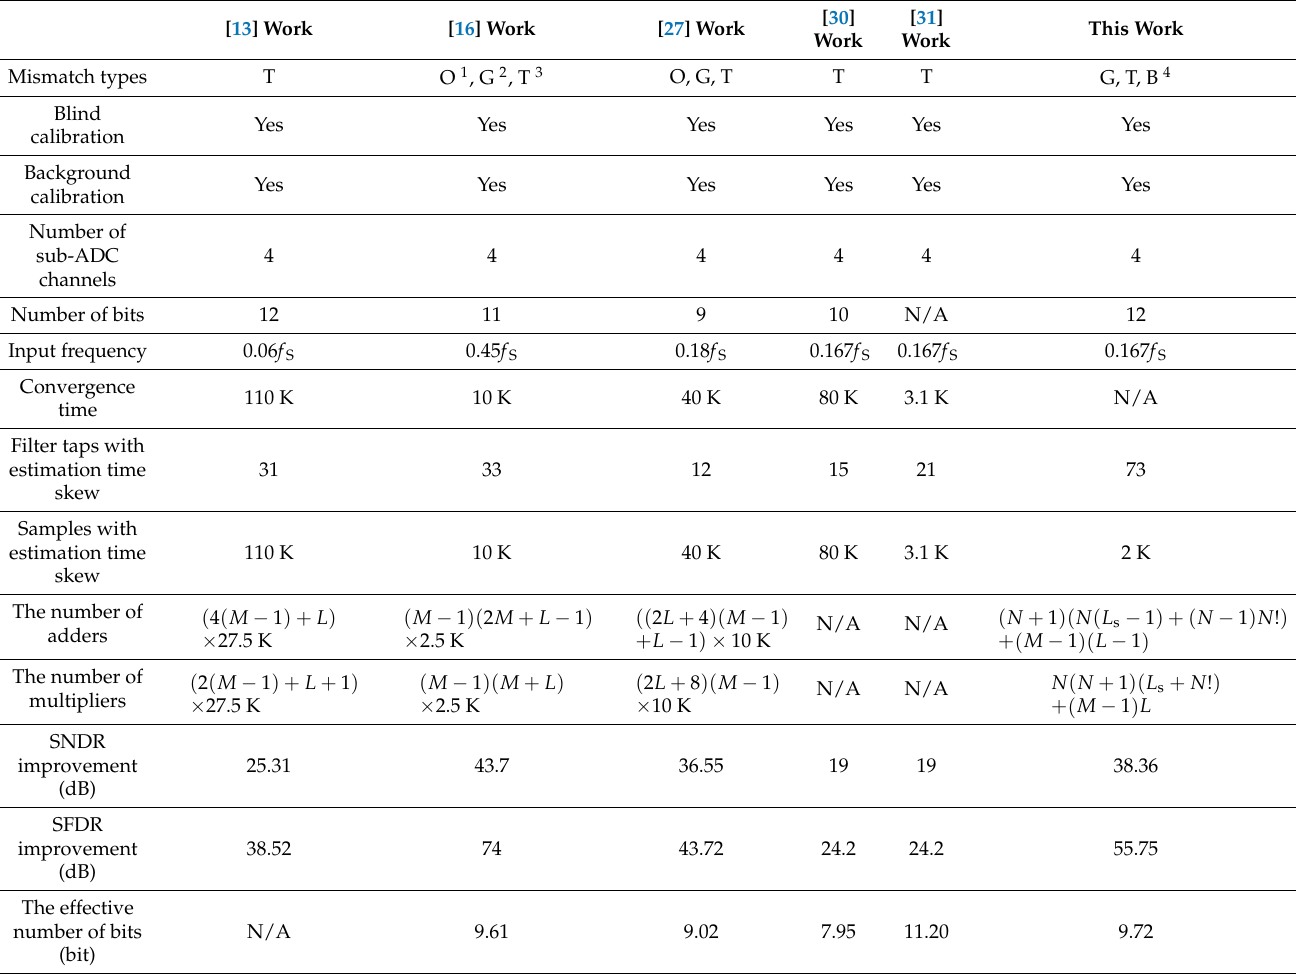
Table 4. Compared with other